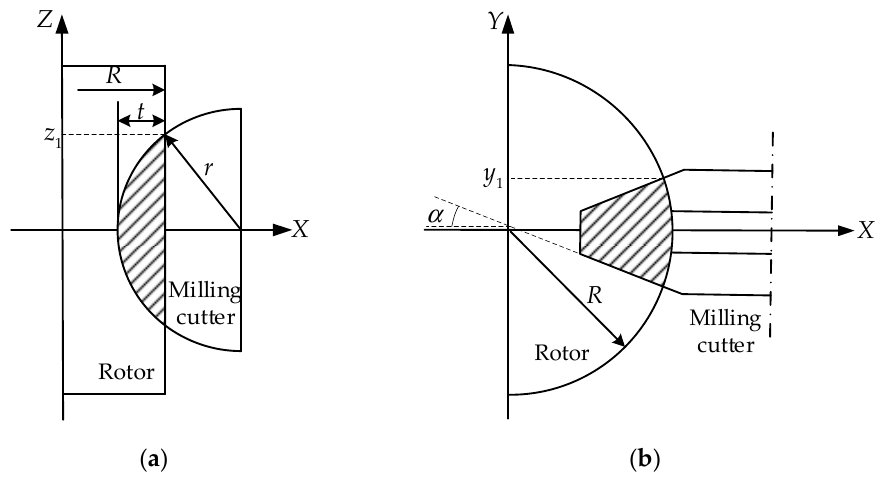
Figure 2. V-shaped milling weight removal model.